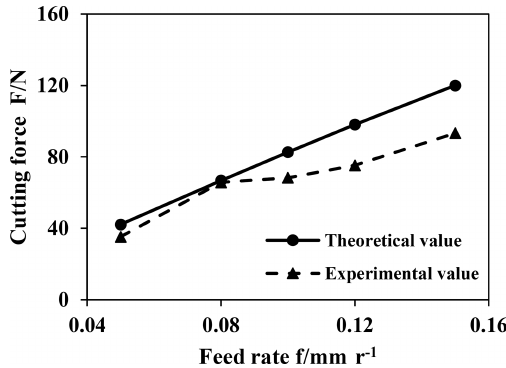
Figure 10. Cutting force varies with feed rate.